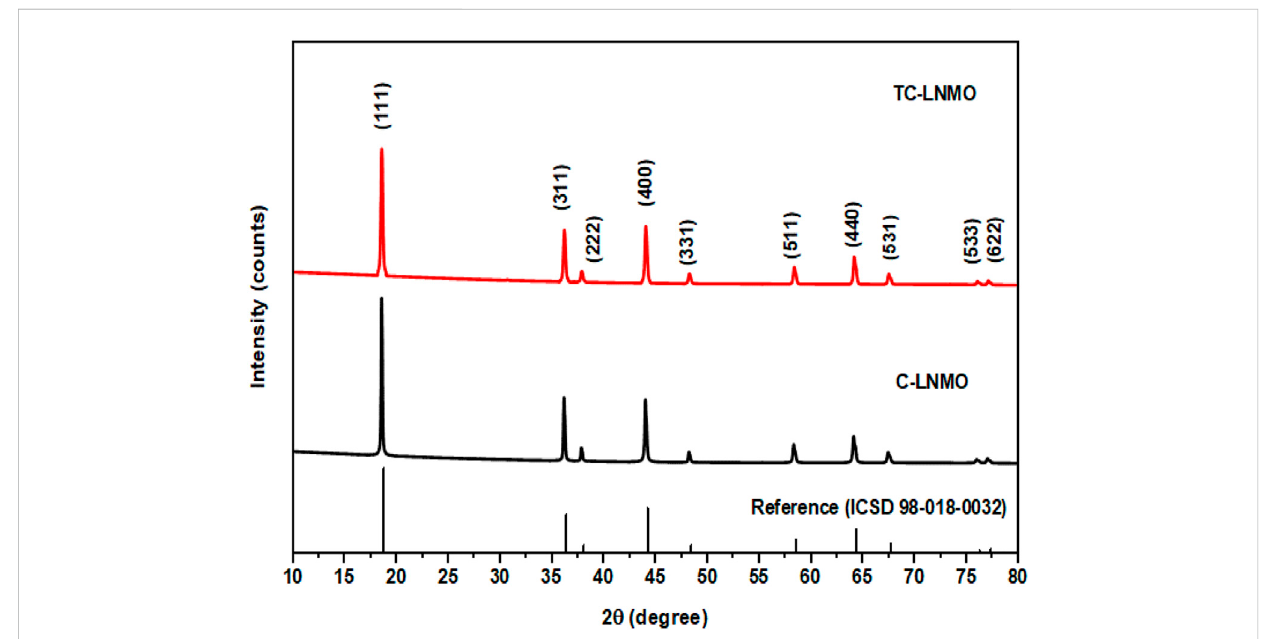
FIGURE 3 Powder XRD pattern of commercial LNMO and synthetic LNMO samples with reference peak of spinel